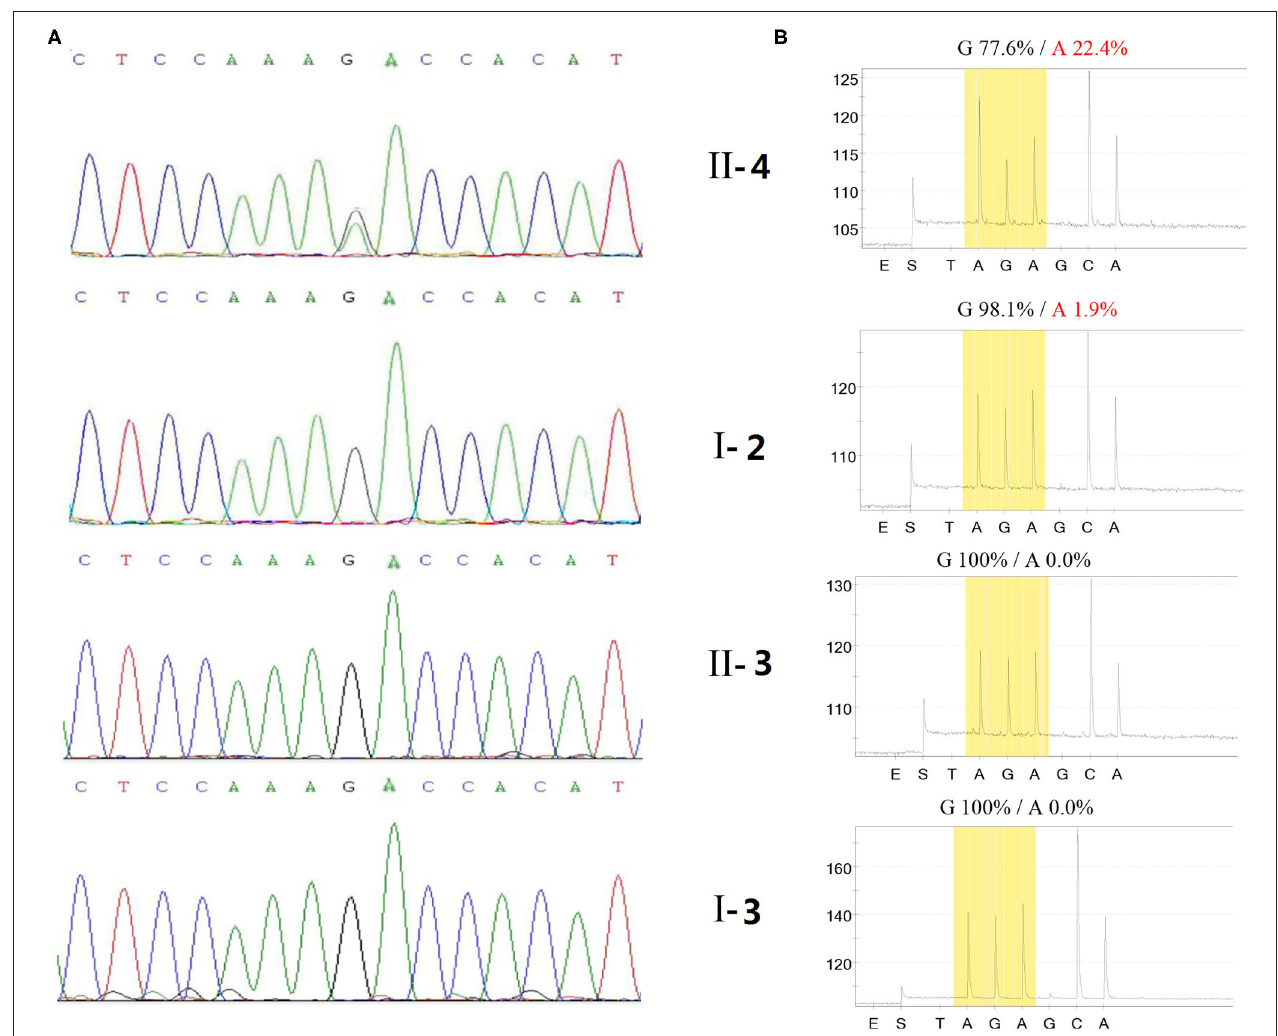
FIGURE 4 | Mutant load of the m.13513G > A mutation in this Chinese LHON family. Test results of m.13513G > A mutation in the LHON patient (II-4), his mother (I-2), his sister (II-3), and his father (I-3) assessed by next generation sequencing (A) and by pyrosequencing (B) ,